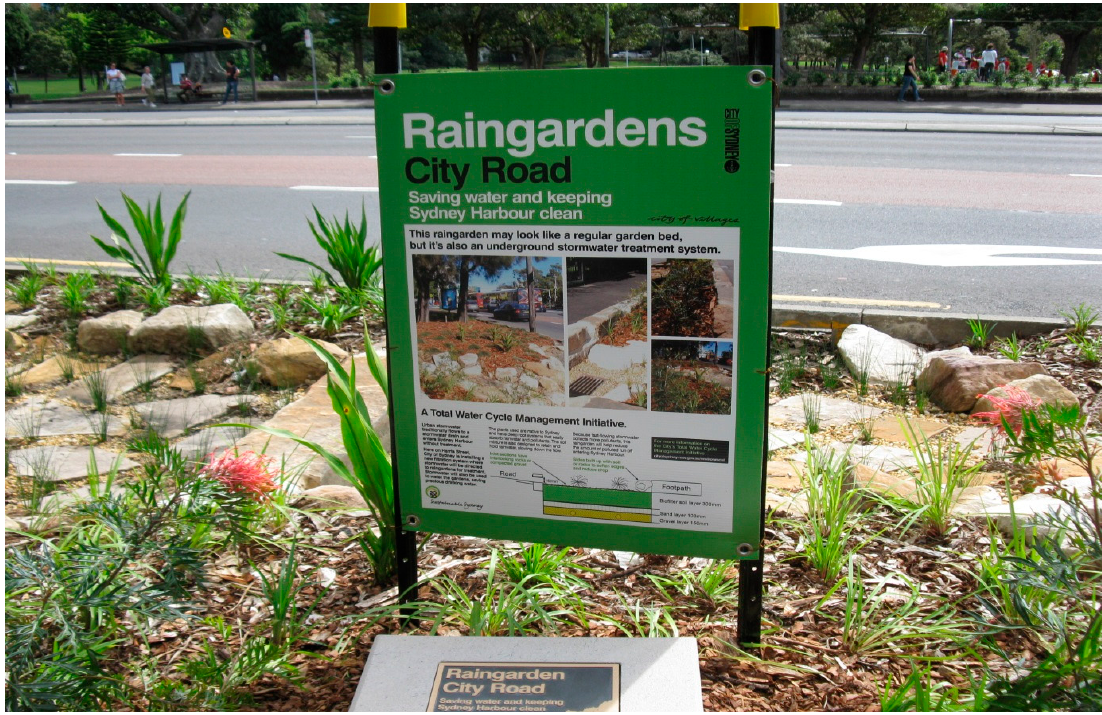
Figure 2. A City of Sydney raingarden.